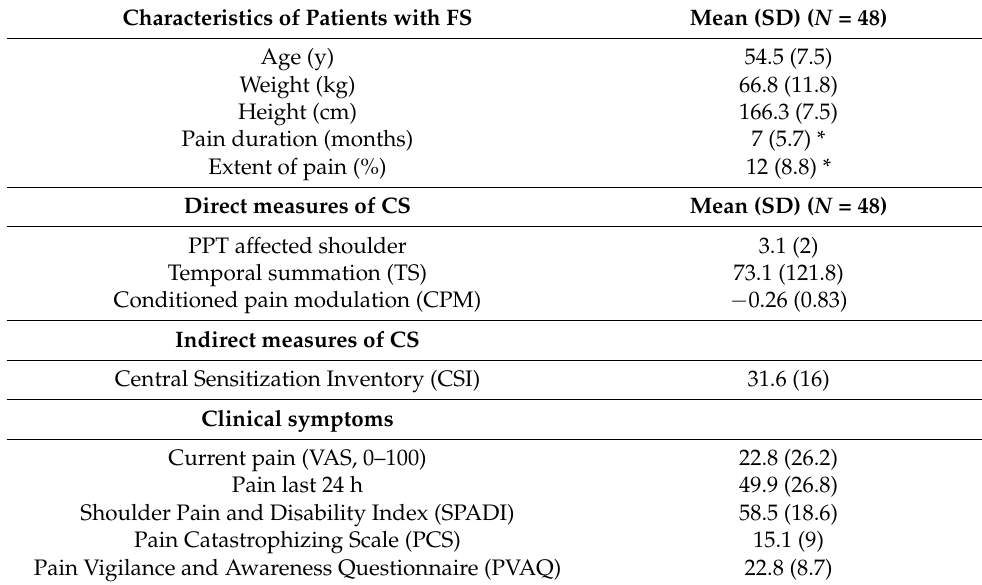
Table 1. Participants’ characteristics. Characteristics of Patients with